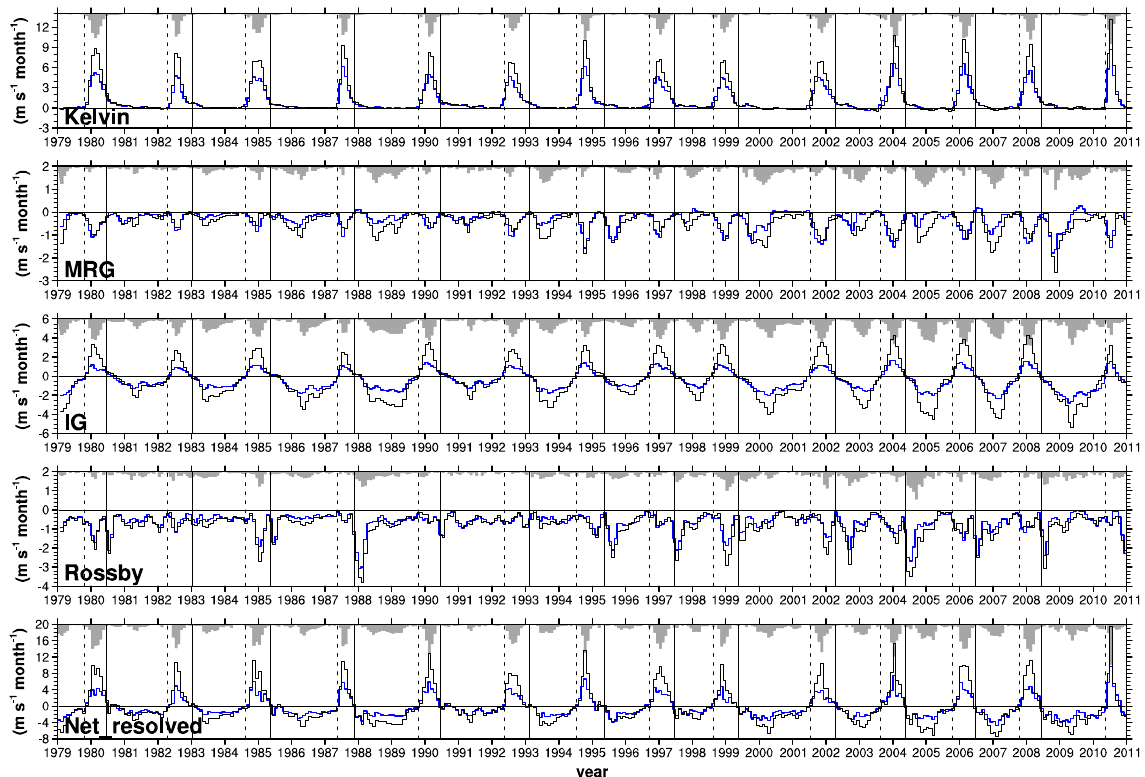
Figure 3. The same as in Fig. 2, except using the model-level data (black) along with the p -level data (blue) for ERA-I.